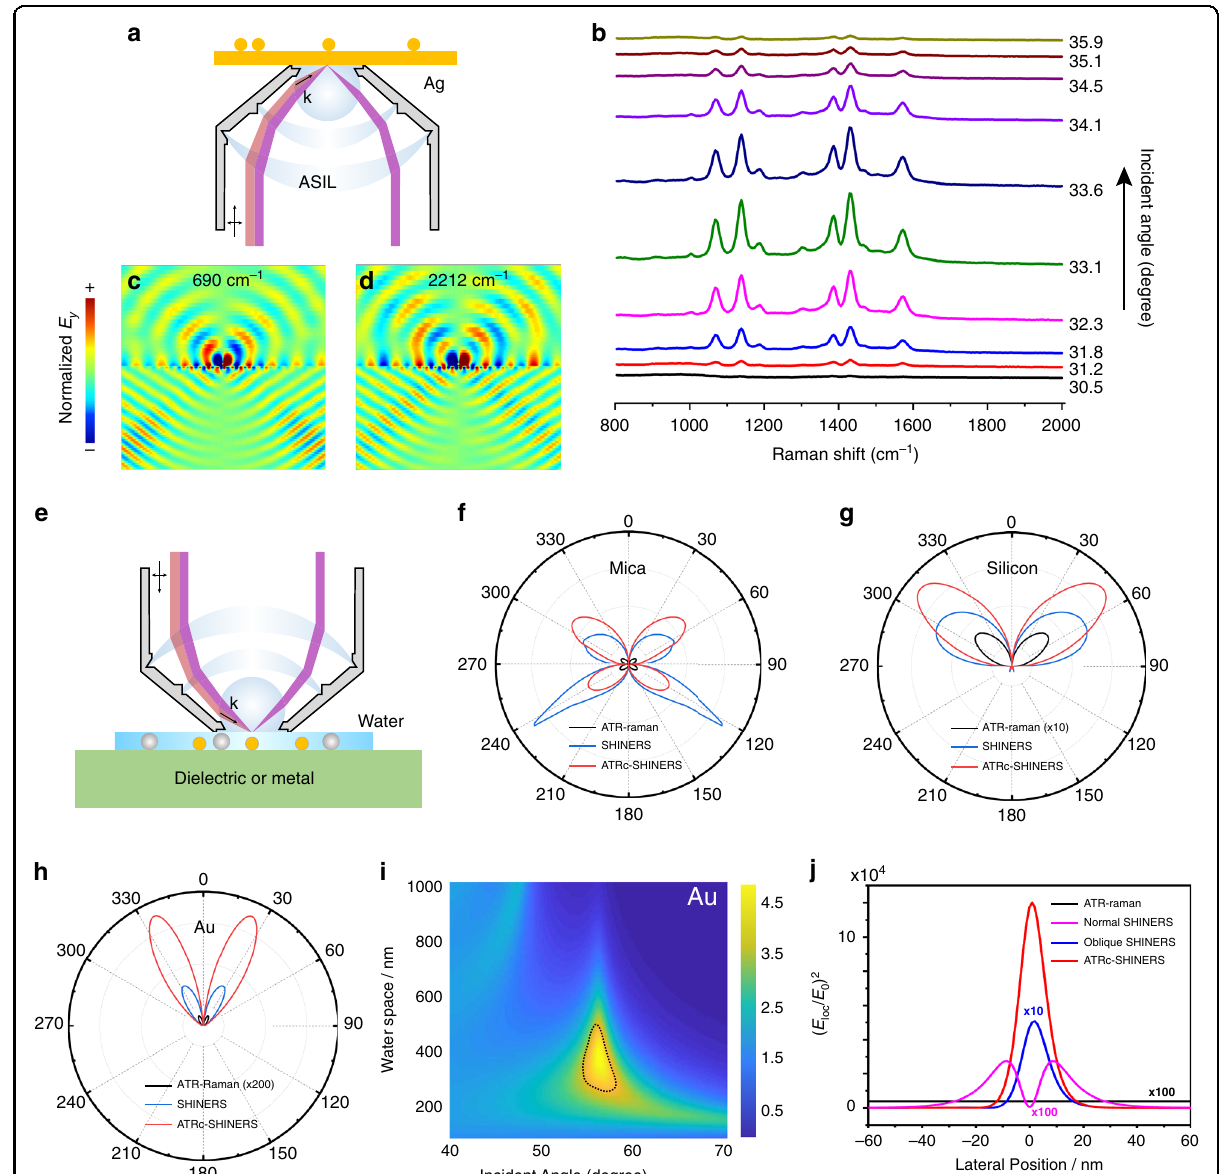
Fig. 11 Excitation and collection optics for nanoparticle on a fi lm. a Custom-designed objective for excitation and collection of nanoparticle on a fi lm for SERS. p -ATP monomolecular layer was assembled on the surface of silver fi lm. b AOI dependent SERS spectra of NOF decorated by p -ATP monomolecular layer. c and d Directional emission of SERS signal (690cm − 1 and 2212 cm − 1 ) from nanoparticle on a fi lm substrate. e Schematics of the ATRc-SHINERS optics 95 . Directional emission of SERS signal in Otto ATR-Raman, SHINERS and ATRc-SHINERS con fi gurations from f Mica and g Si substrates. h Directional emission of SERS signal in ATR-Raman, SHINERS and ATRc-SHINERS con fi gurations from an Au substrate. The Raman- scattered wavelength is 700 nm, corresponding to the Raman shift at 1,500cm − 1 . i Incident angle and thickness of water space-dependent electrical fi eld on the Au surface. Excitation wavelength is 633 nm. j Local fi eld enhancement with different excitation optics